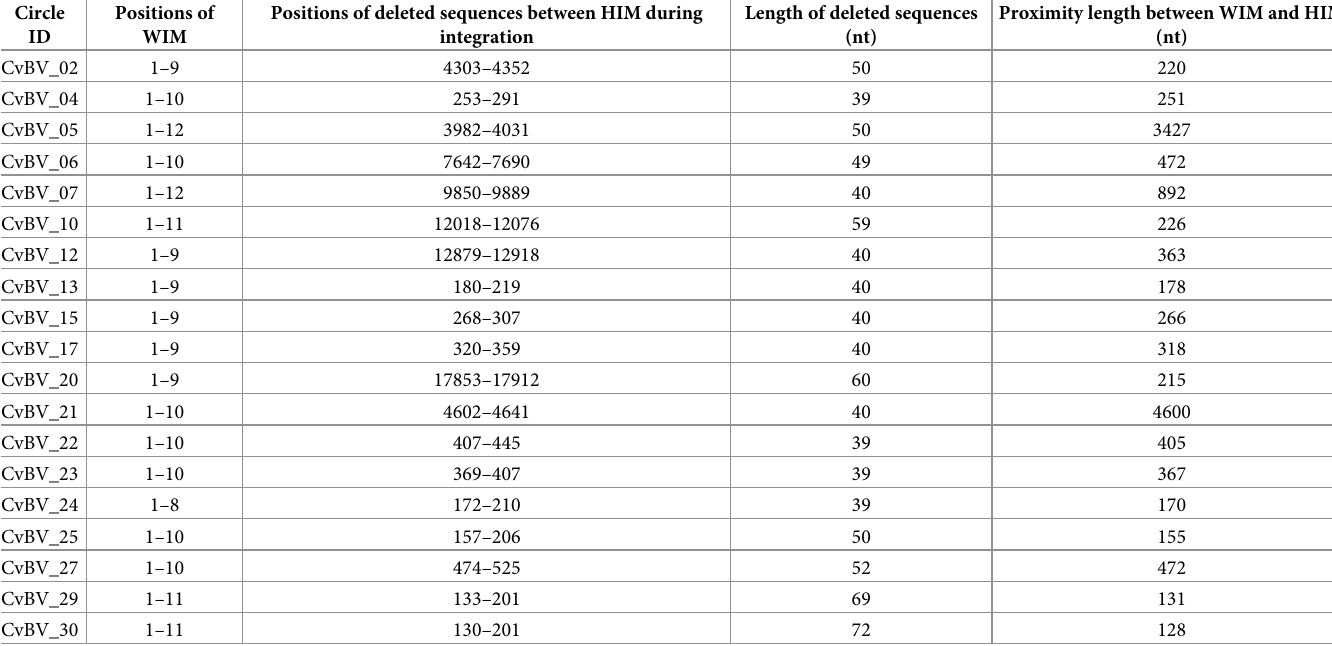
Table 1. The information of HIM regions for Conservative-Broken CvBV circles (CBCs). Circle Positions of Positions of deleted sequences between HIM during ID WIM